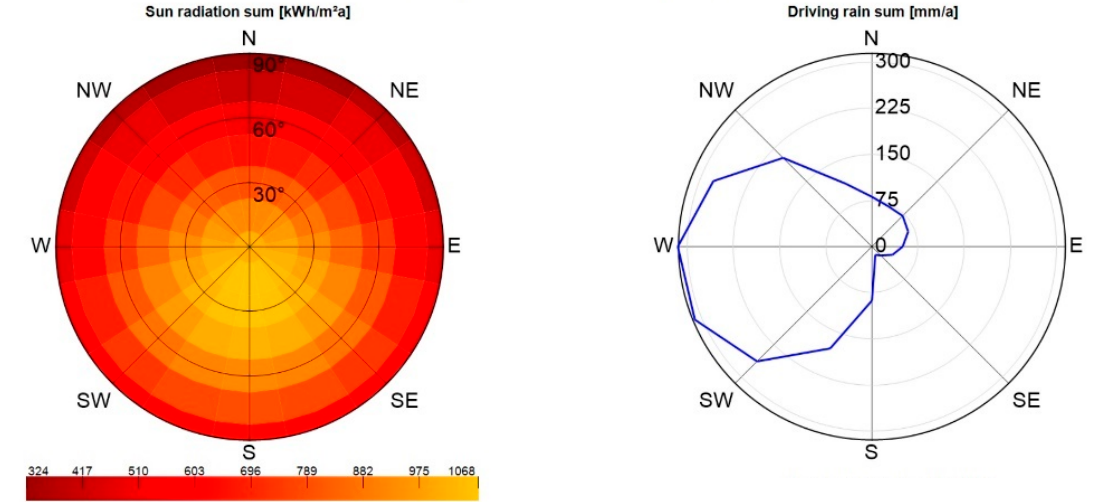
Figure 6. Characterisation of solar radiation and annual precipitation used in the model (Krakow, Technical University Lodz).